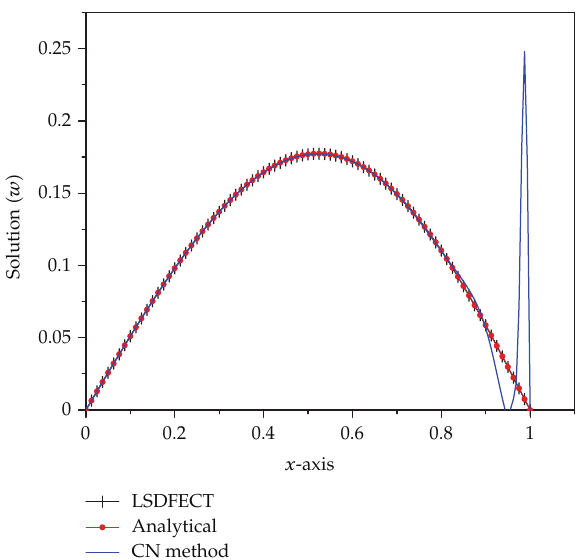
Figure 4: Comparison of the numerical solution by our method (cid:2) LSDFECT (cid:3) , CN method, and exact solution of Problem 4 at di ff erent space points for N (cid:8) 80, ν d (cid:8) 2, and k (cid:8) 0 . 01 at T (cid:8) 0 .